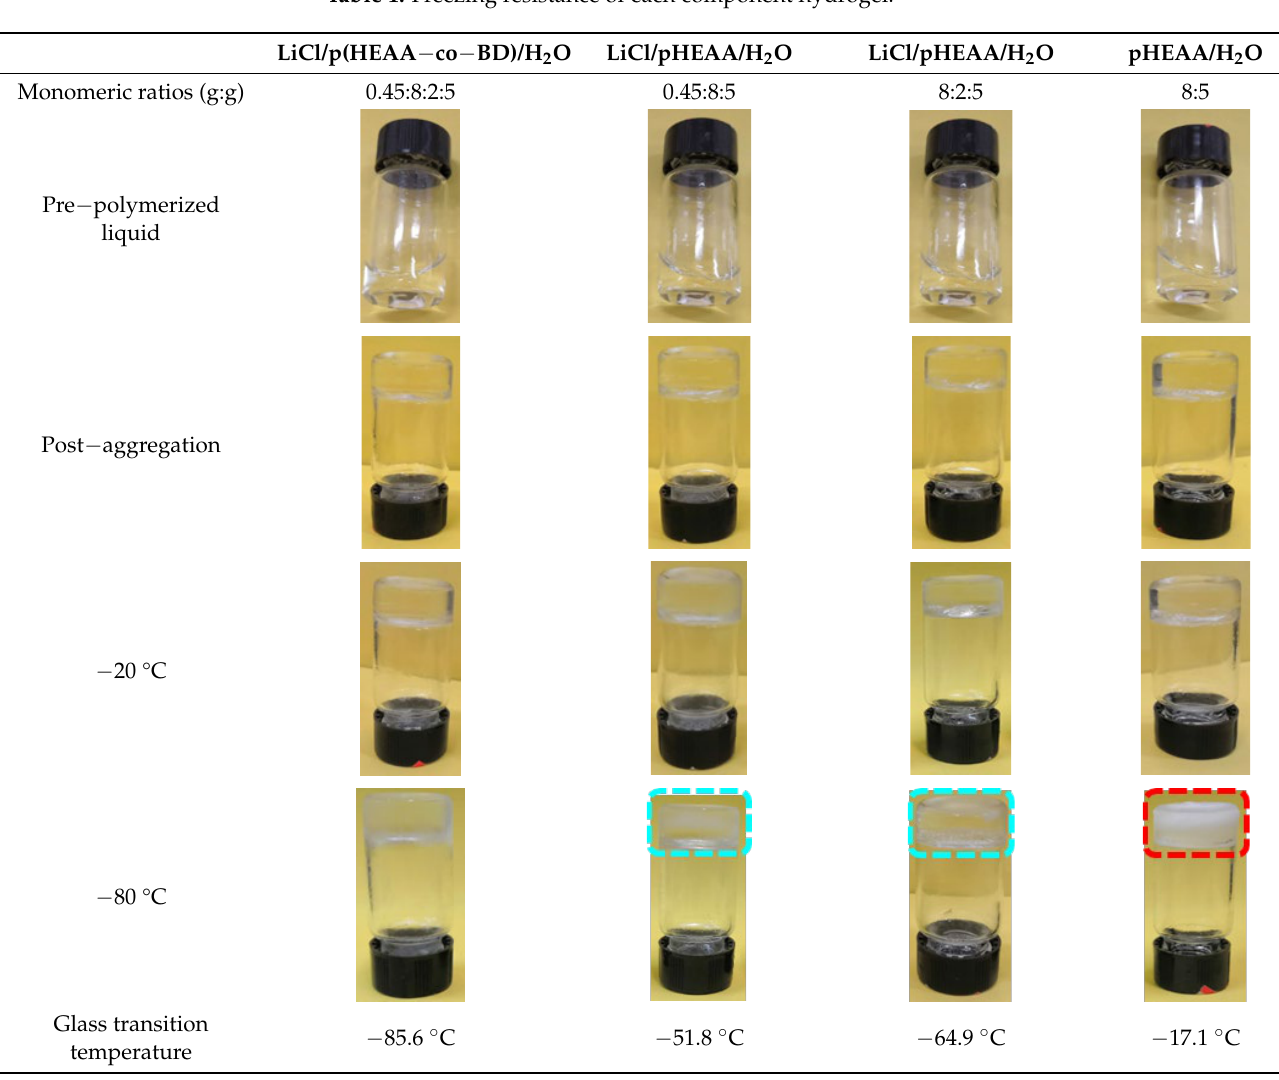
Table 1. Freezing resistance of each component hydrogel.